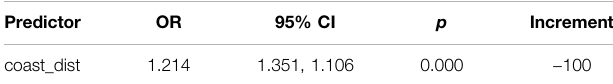
TABLE 4 | Summary of the logistic regression model of range shift. Results are given with 95% con fi dence intervals (CI) and p -values. OR is the odds ratio